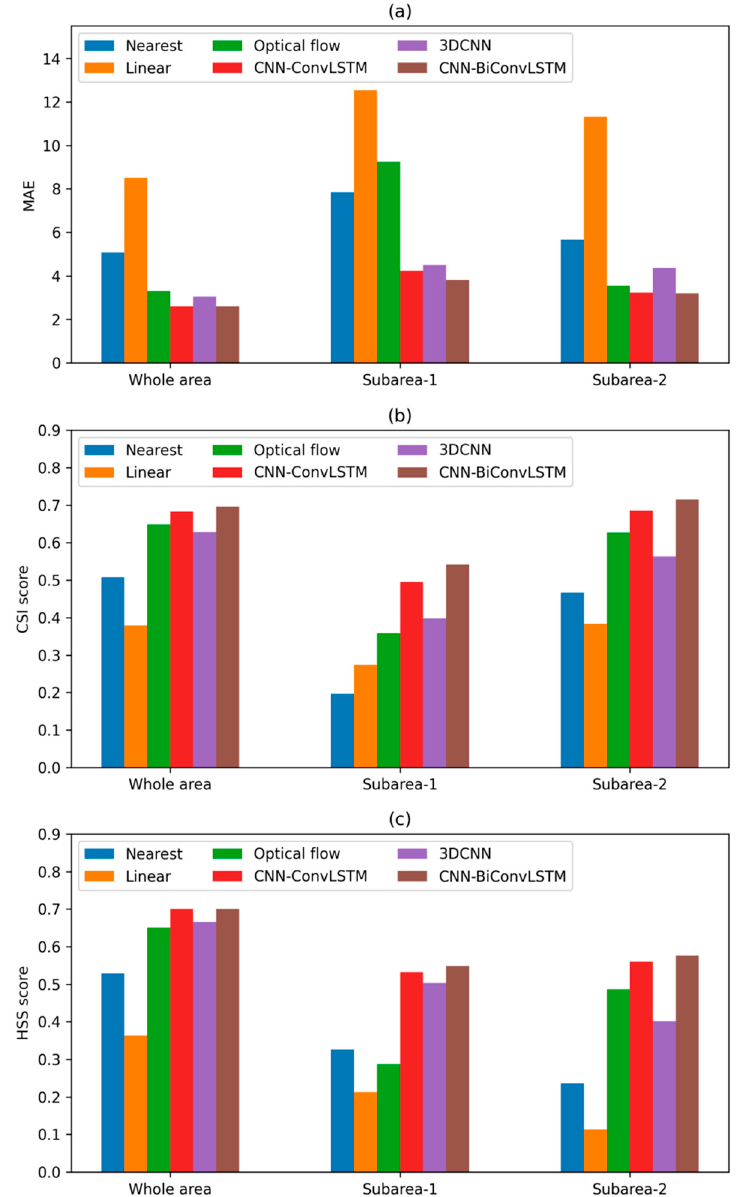
Figure 10. Evaluation results of MAE ( a ), CSI-30 scores ( b ), and HSS scores ( c ) for the example shown in Figure 9. Subarea-1 and subarea-2 correspond to the red box and the black box in Figure 9, respectively.